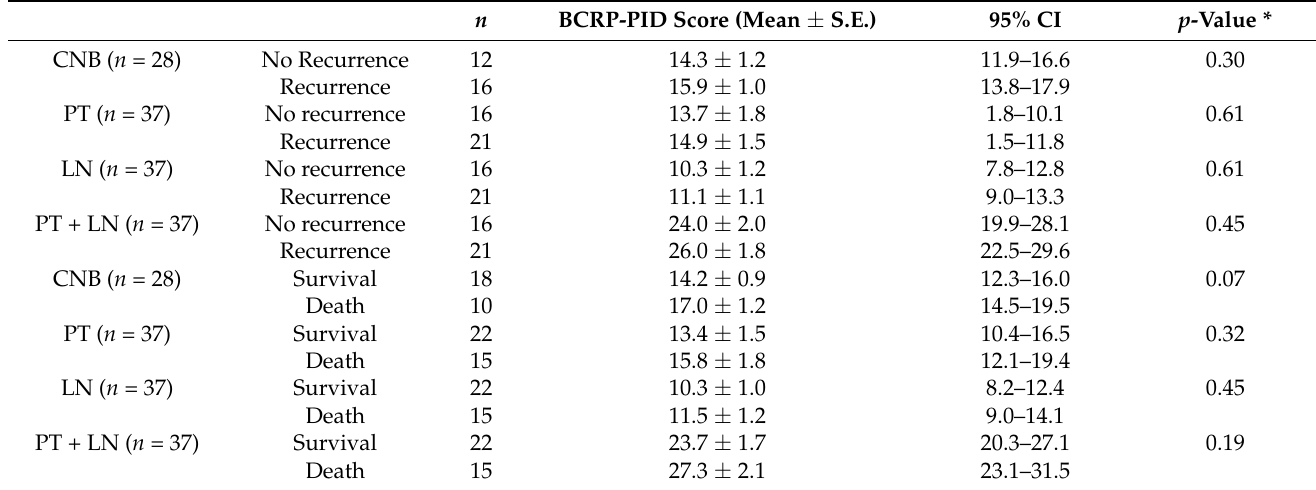
Table 3. Correlations between BCRP-PID score and recurrence or